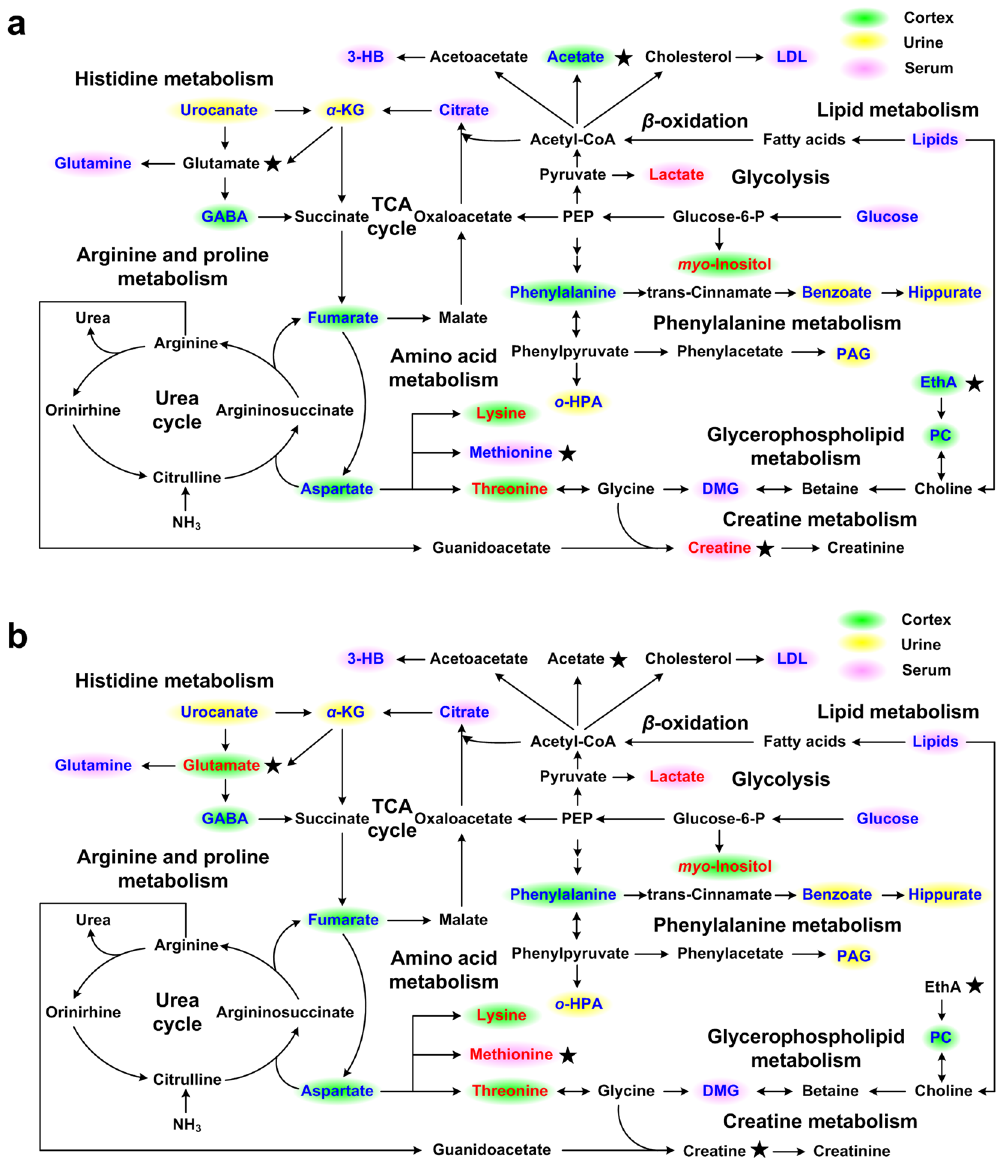
Figure 8. Summaries of metabolic pathways altered after EA stimulations. ( a ) delineates SMFY group, and ( b ) GMFS group. Metabolites displayed with red (or blue) present concentration significantly increases (or decreases) in comparison with the control group; those in black indicate no significant changes; the metabolites with ★ indicate exclusive metabolites changes for SMFY or GMFS groups. PEP,